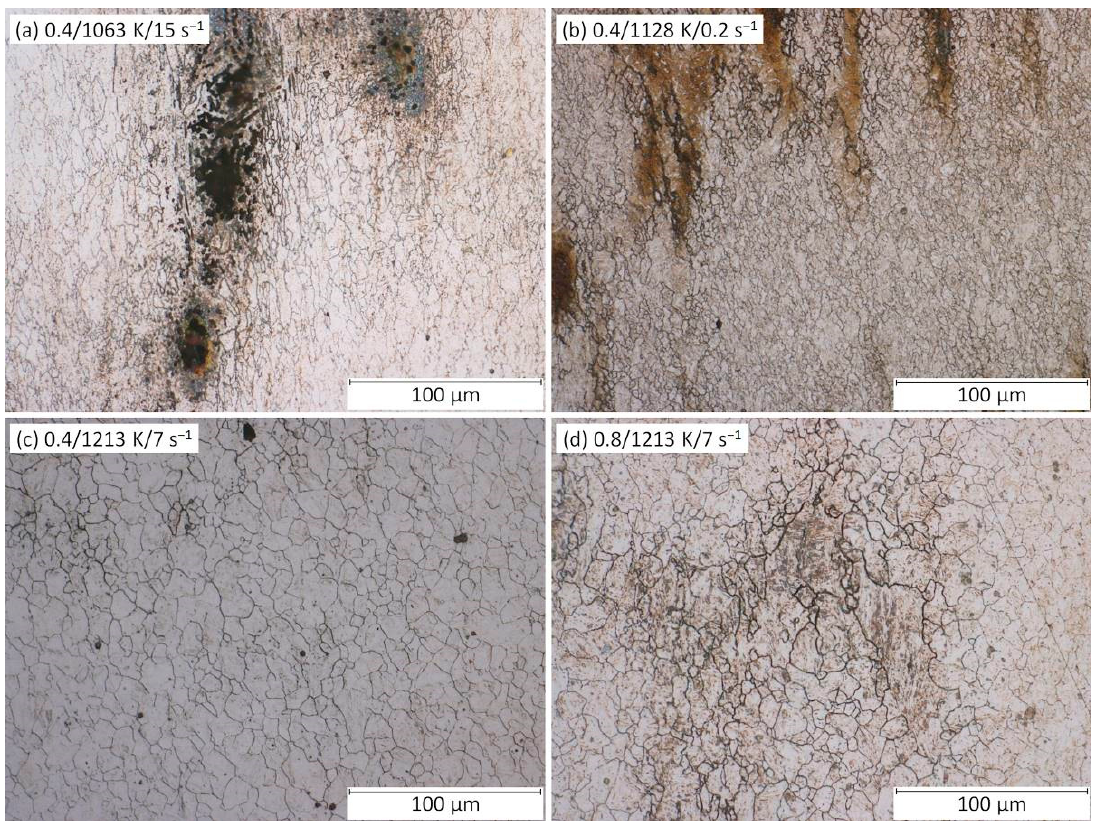
Figure 9. OM images of samples deformed under various strains. ( a ) 0.4/1063 K/15 s − 1 ; ( b ) 0.4/1128 K/0.2 s − 1 ; ( c ) 0.4/1213 K/7 s − 1 ; ( d ) 0.8/1213 K/7 s − 1 .